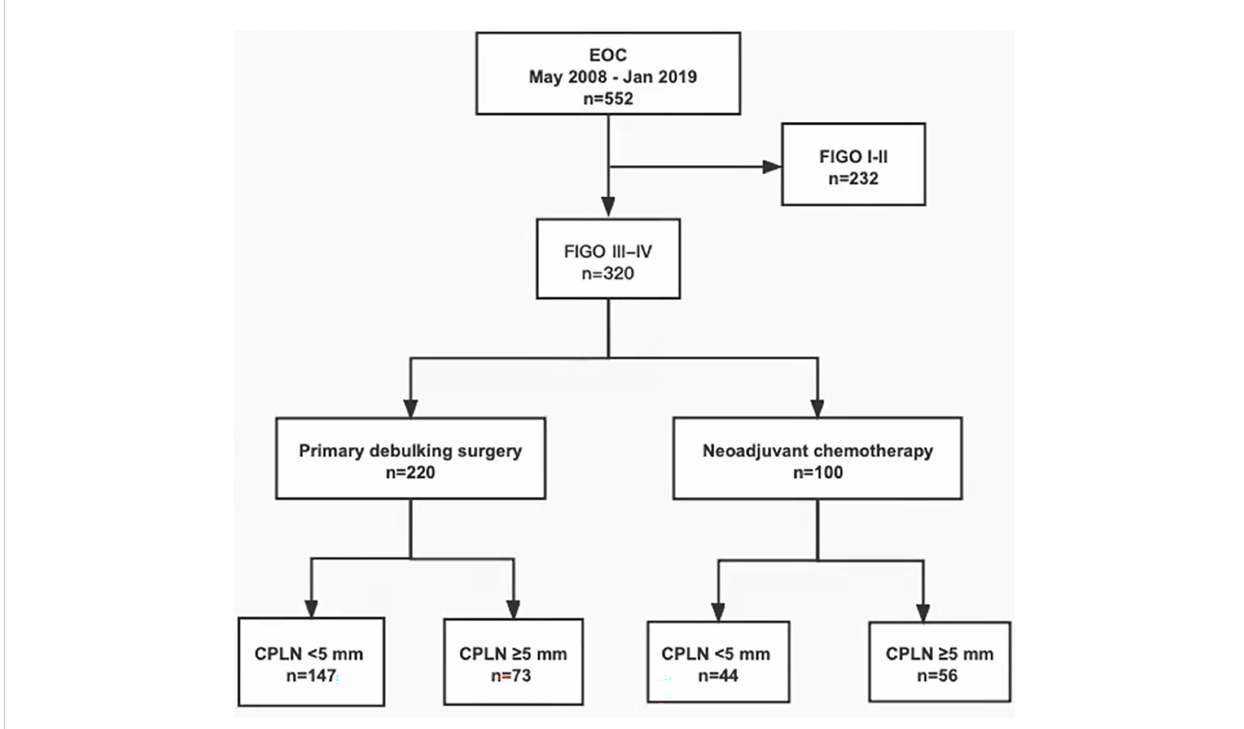
FIGURE 1 Flowchart showing patient fl ow of the patient population involved in the study. EOC, epithelial ovarian cancer; FIGO, International Federation of Gynecology and Obstetrics; CPLN, cardiophrenic lymph